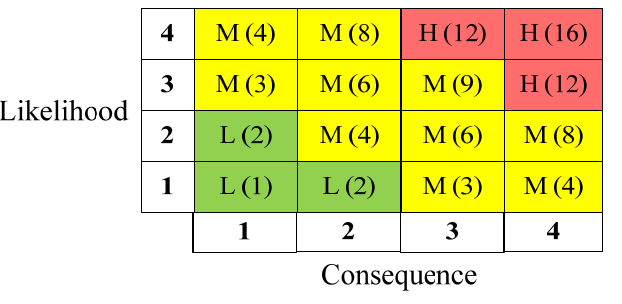
Figure 3. The traditional risk matrix.